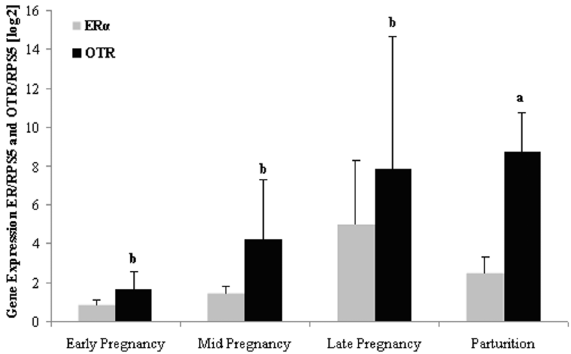
Figure 1. Relative expression of estrogen receptor ( ER a ) and oxytocin receptor ( OTR ) in the endometrium during Early (n=11), Mid (n=12) and Late pregnancy (n=12) and Parturition (n=11). a,b Significantly different among groups (P , 0.05, LSD test).